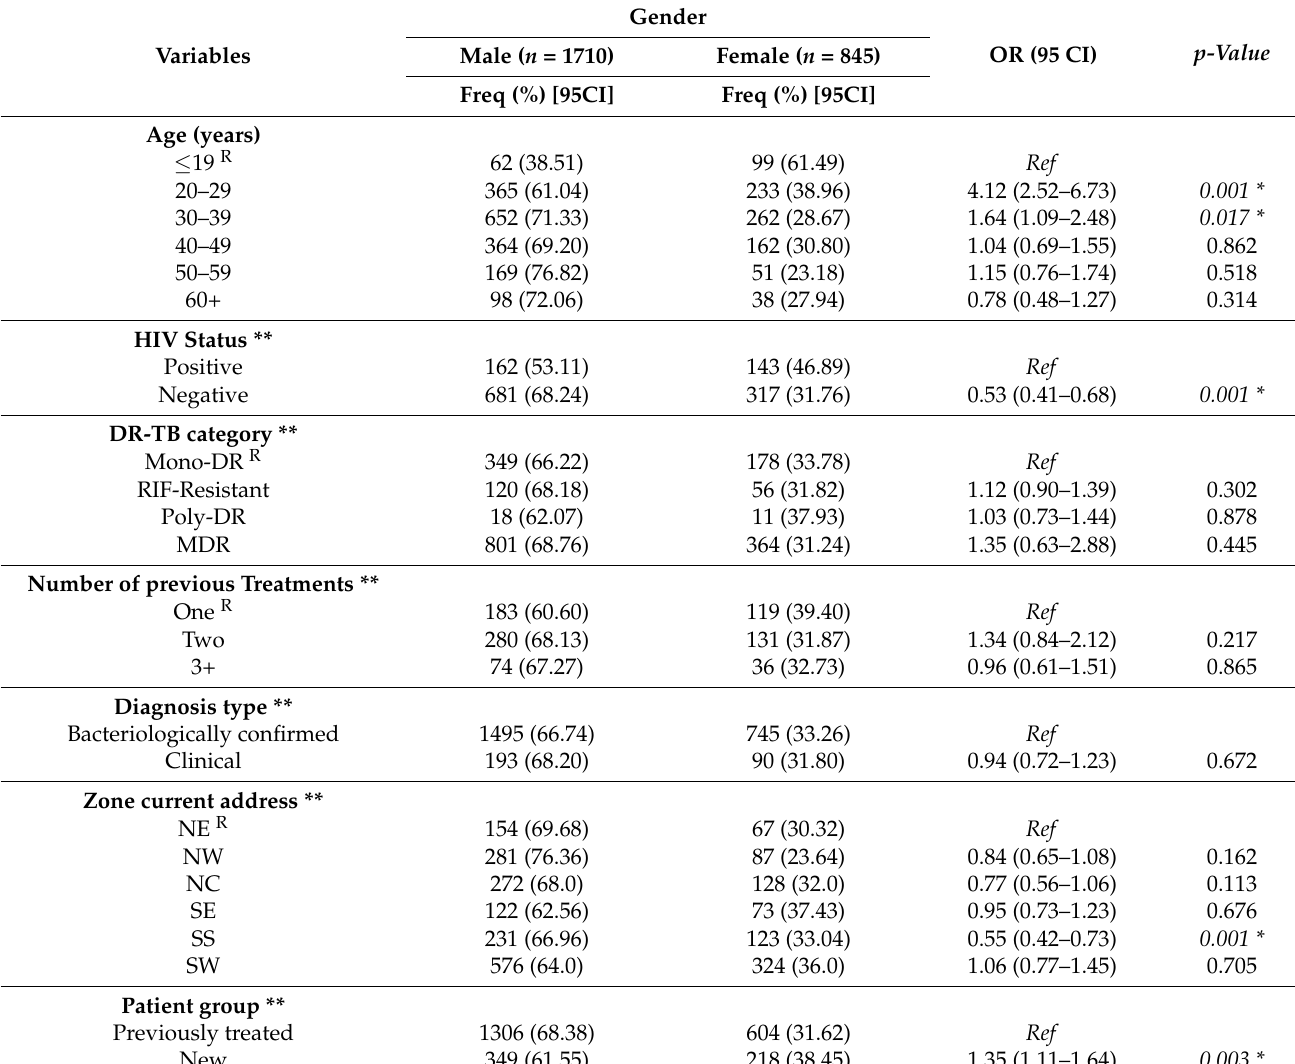
Table 2. Association of gender and DR-TB cases in Nigeria (2010–2016) ( n = 2555)